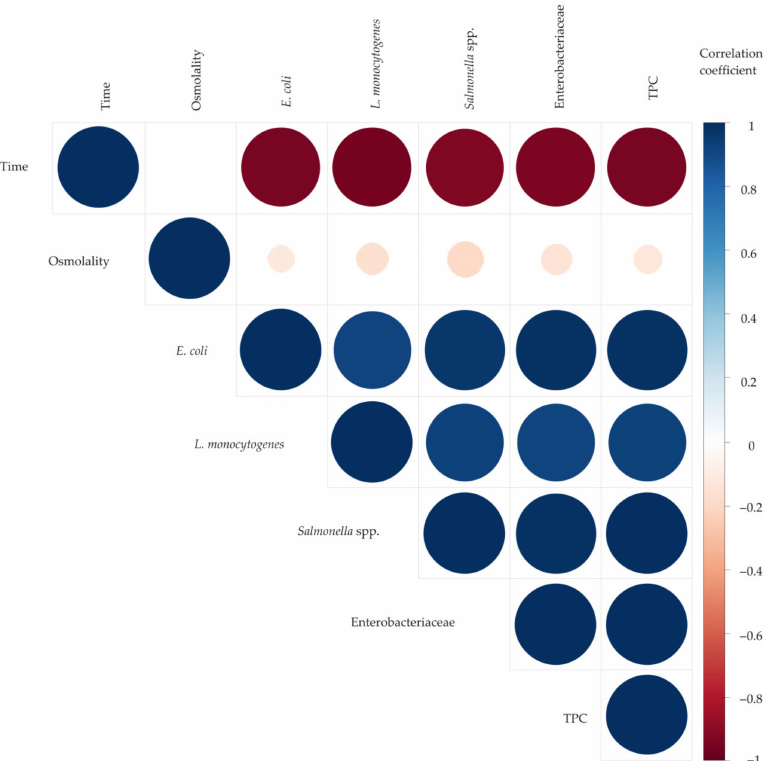
Figure 2. Color correlation diagram between the parameters of the independent variables and the responses of microorganisms’